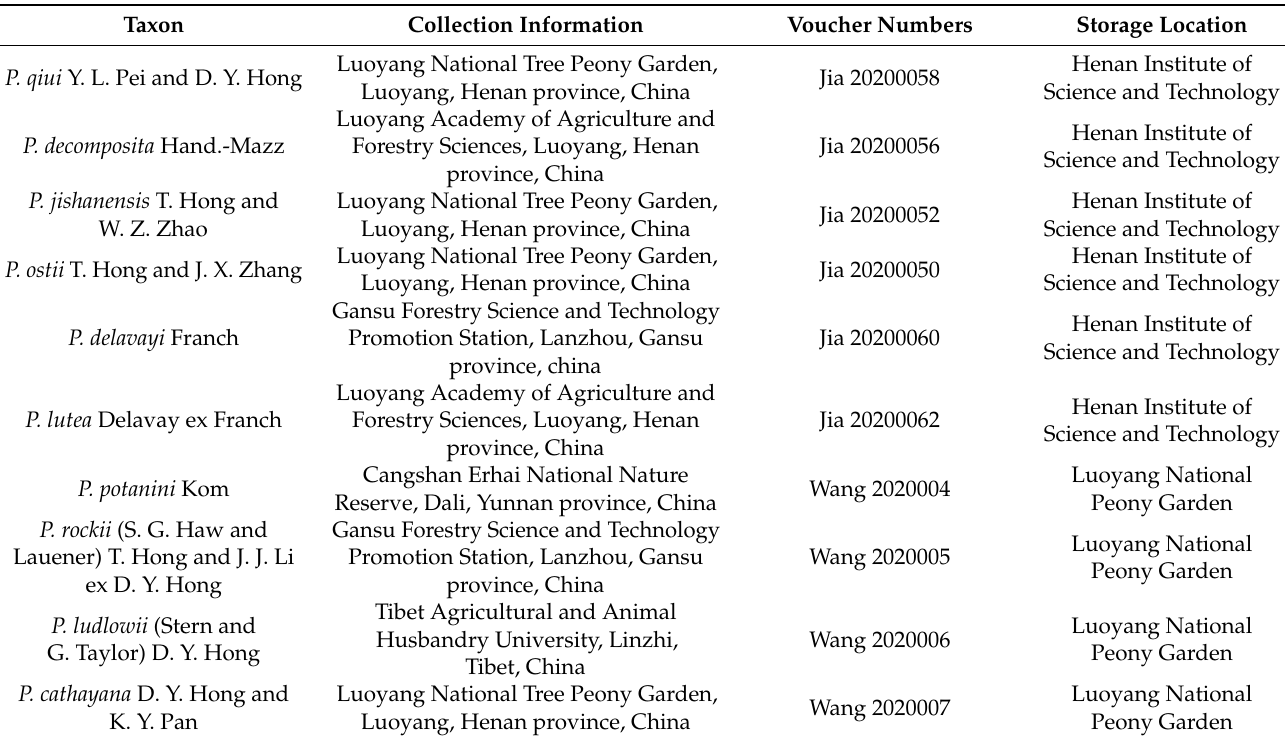
Table 1. Sources of ten wild tree peonies used for the